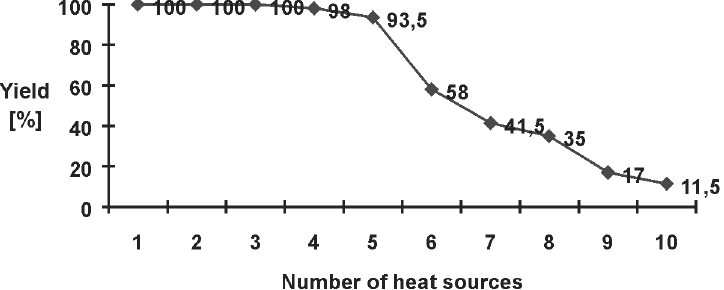
FIGURE 7 The algorithm yield versus the number of heat sources having successively increasing values from 0.1 to 1.0 ( e.g. for 3 sources their power values are 0.1, 0.2 and